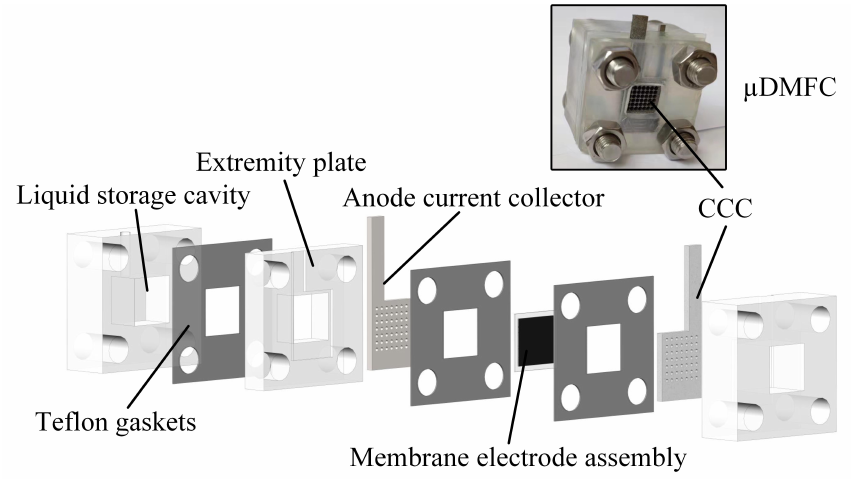
Figure 1. Schematic diagram of µ DMFC.